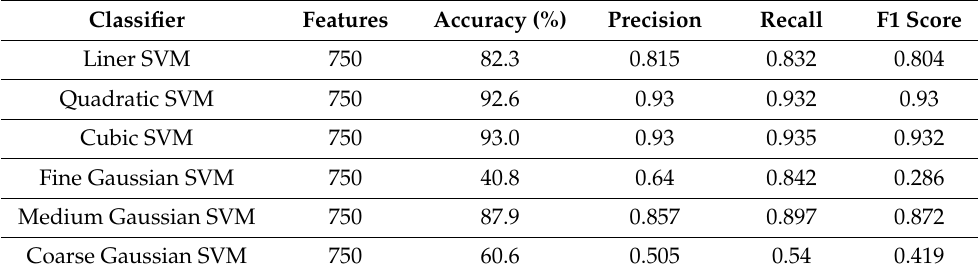
Table 3. Experiment Setup 3.